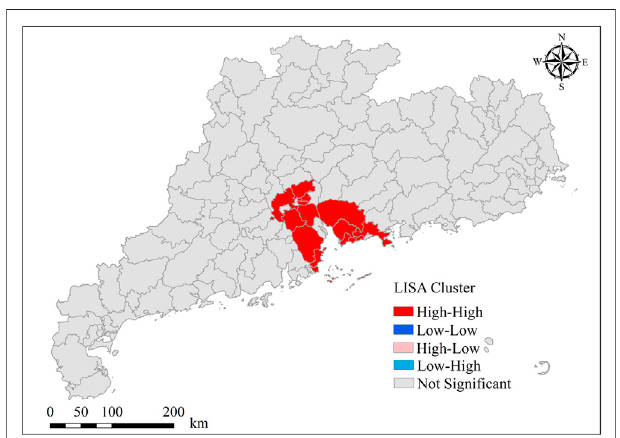
FIGURE 7 | Spatial distribution of local Moran ’ s I at the county level in Guangdong.